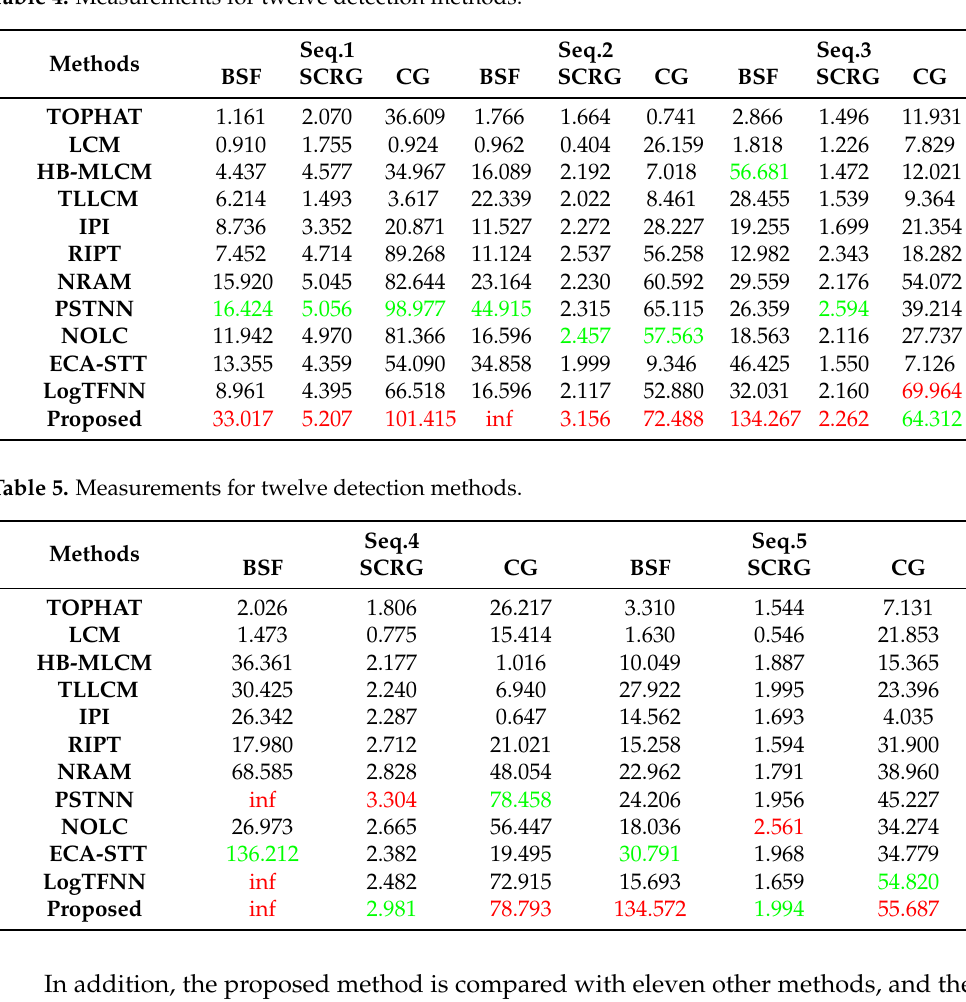
Table 4. Measurements for twelve detection methods.